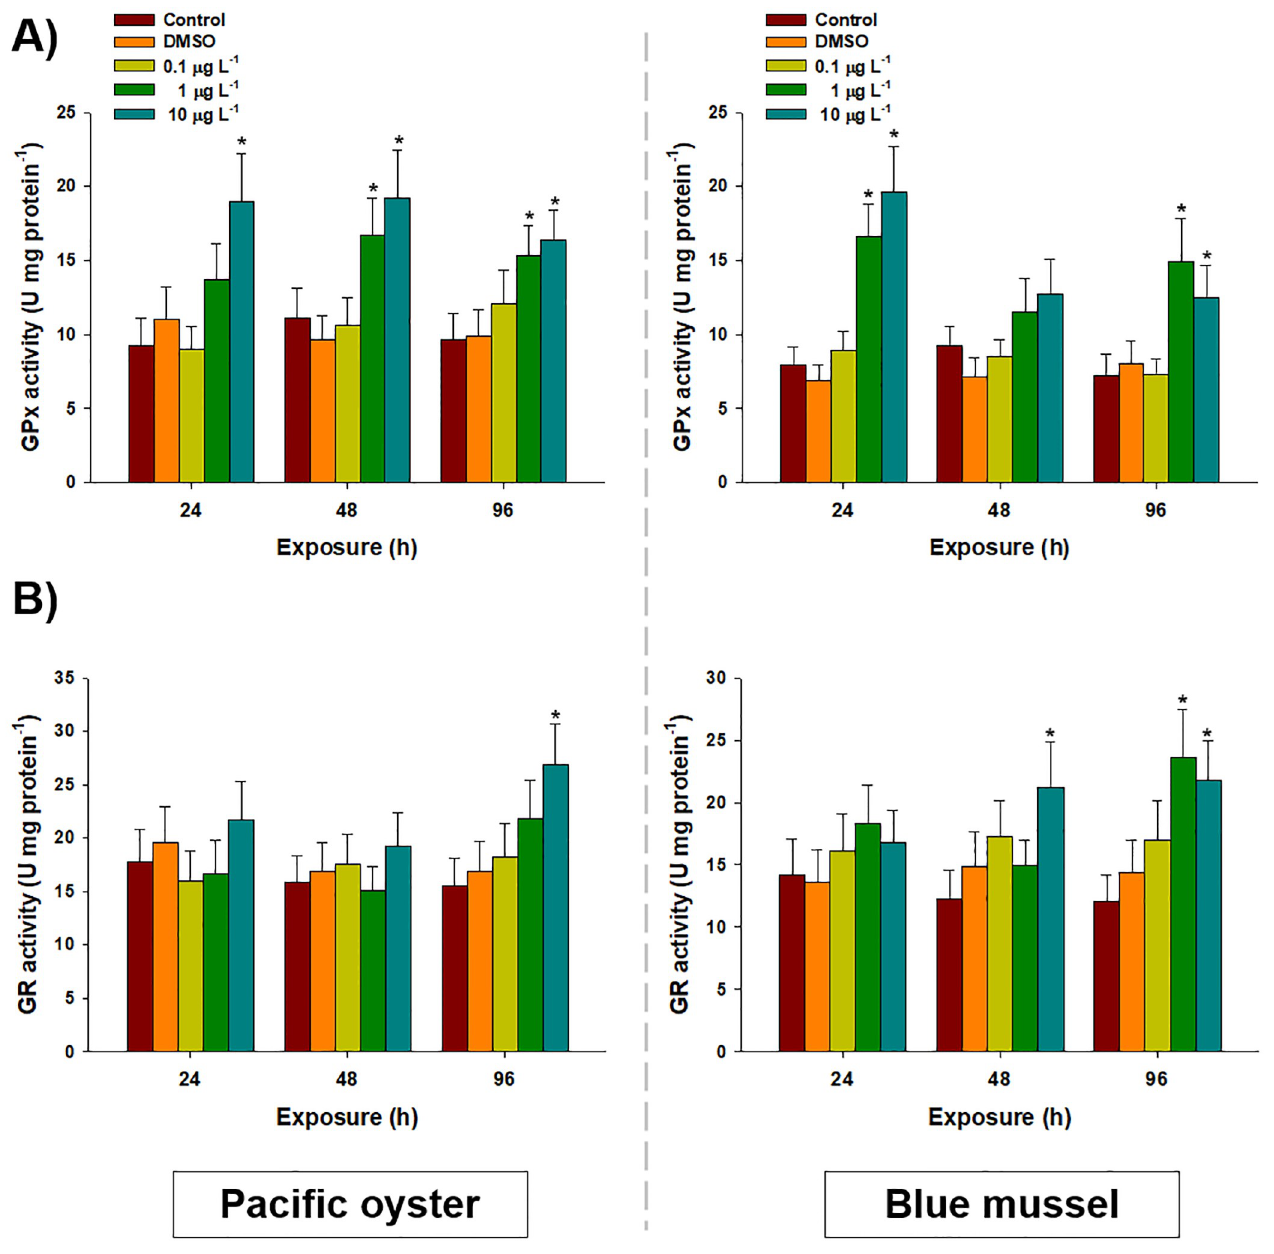
Fig 3. Effects of waterborne chlorothalonil on enzymatic oxidative stress parameters of marine bivalves. Effects of different concentrations of chlorothalonil (0.1, 1.0, and 10.0 μ g L -1 ) on (A) glutathione peroxidase (GPx) and (B) glutathione reductase (GR) levels in the gill tissues of Pacific oysters ( Crassostrea gigas) and blue mussels ( Mytilus edulis) over 96 h. Data are expressed as the mean ± standard deviation (S.D.). An asterisk ( � ) indicates significant differences compared to control ( P < 0.05).